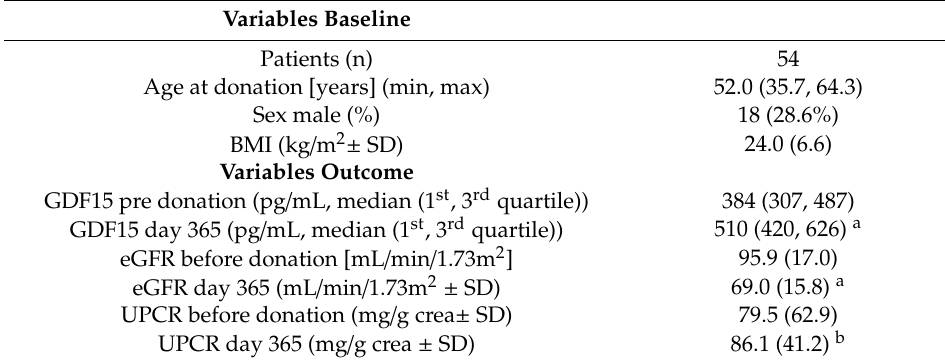
Table 3. Kidney donors: Baseline characteristics and laboratory results.